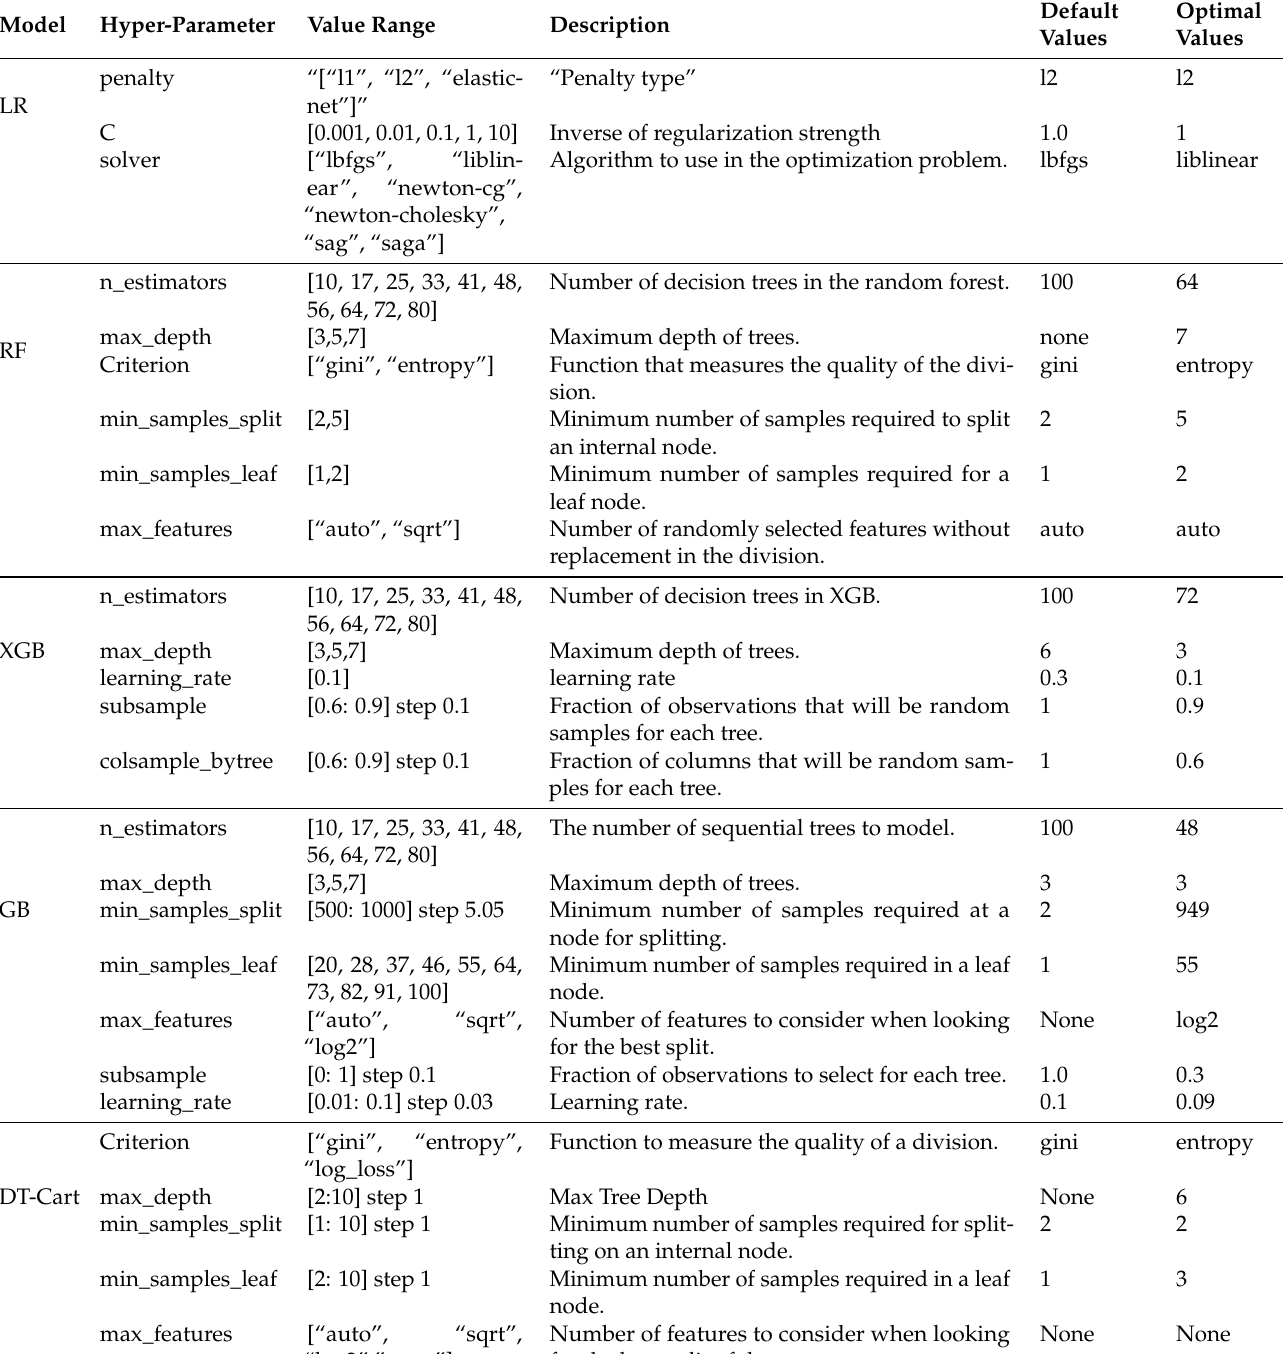
Table 4. Hyper-parameter